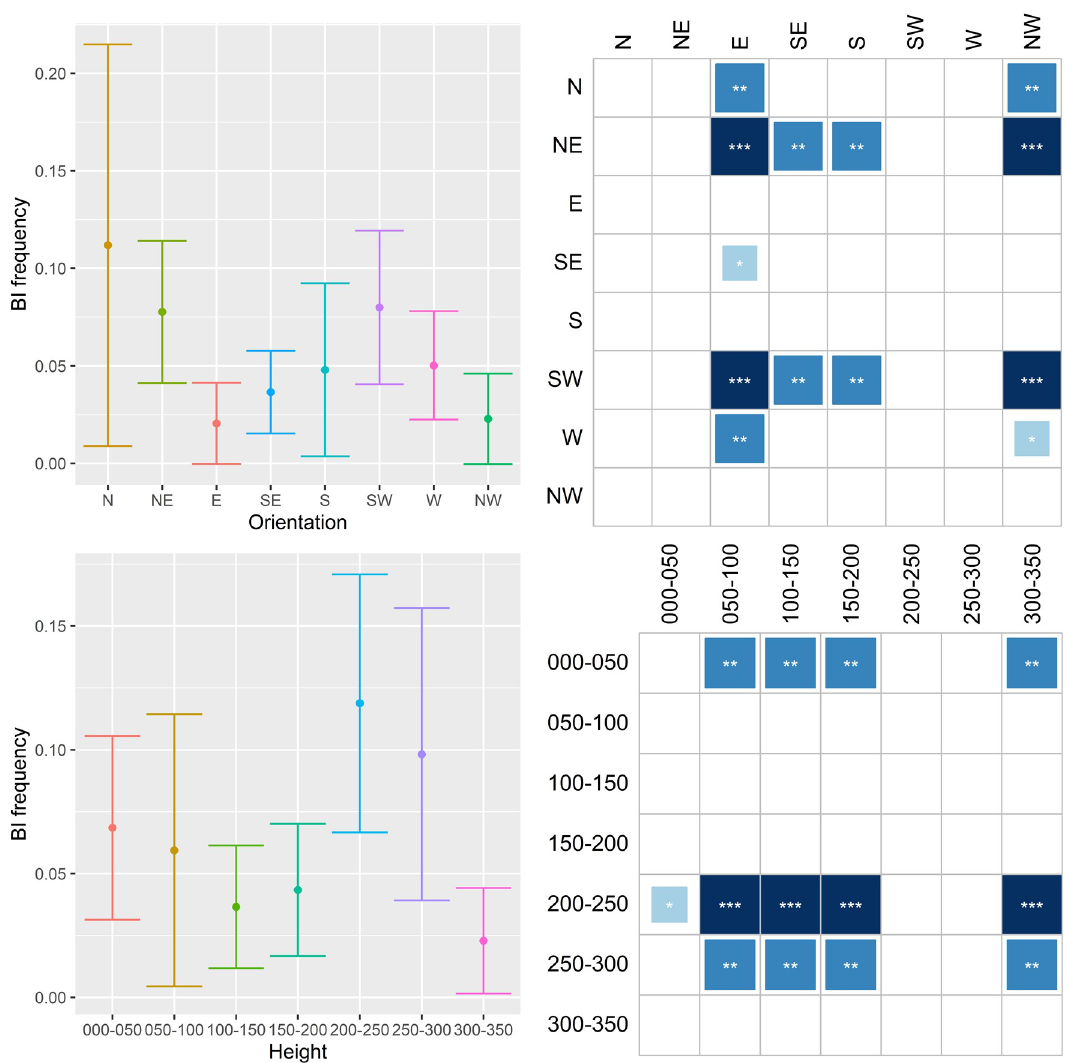
Fig 12. Distribution of bark injuries (BI) on orientation and